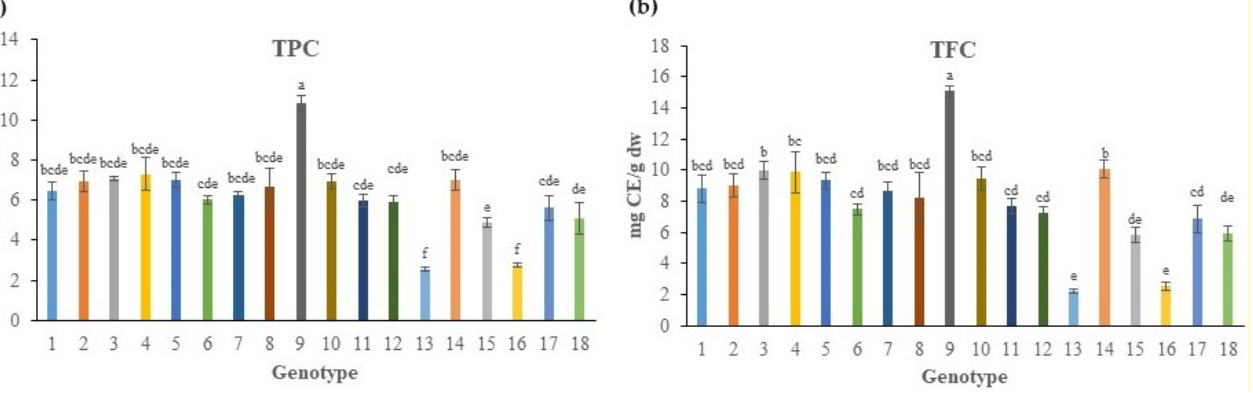
Figure 2. The content of total phenolic compounds (TPC) ( a ), expressed as mg of gallic acid equiva- lents (GAE) per g of dry weight (dw), and total flavonoid compounds (TPC) ( b ), expressed as mg of catechin equivalents (CE) per g of dw in the extracts of aboveground portion of 18 native Greek rock samphire genotypes. Data represent the mean values ± standard deviation. Different letters on the bars characterize significant differences among genotypes according to Tukey’s test for p ≤ 0.05.